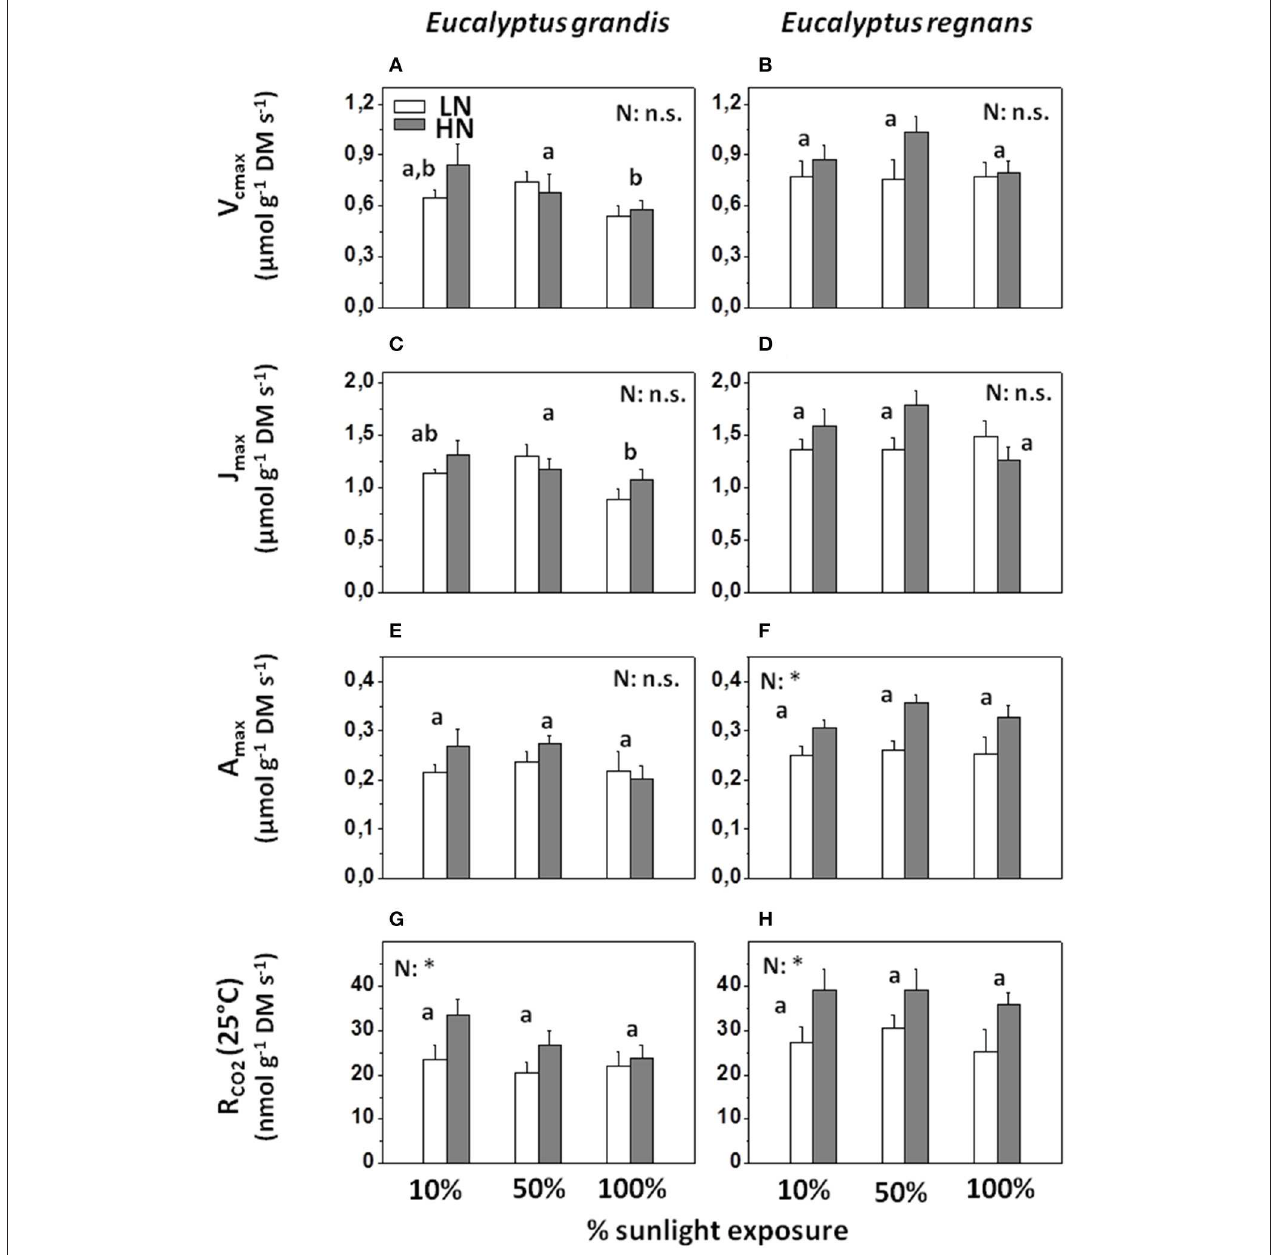
FIGURE 4 | Photosynthetic capacity and CO 2 dark-respiration (at 25 ◦ C) of Eucalyptus under differing N-nutrition and light intensity, determined via Infrared Gas Analysis. (A) Source-leaf V cmax in Eucalyptus grandis . (B) Source-leaf V cmax in Eucalyptus regnans . (C) Source-leaf J max in Eucalyptus grandis . (D) Source-leaf J max in Eucalyptus grandis Eucalyptus regnans . (E) Source-leaf A max in Eucalyptus grandis . (F) Source-leaf A max in Eucalyptus regnans . (G) Source-leaf R CO2 (CO 2 dark respiration at 25 ◦ C) in Eucalyptus grandis . (H) Source-leaf R CO2 (CO 2 dark respiration at 25 ◦ C) in Eucalyptus regnans . Open columns: “low” N-supply (LN: 2.6mM N). Gray columns: “high” N-supply (HN: 8.1mM N). Each column shows the average ± SE of 5–6 independent replicates. Different letters indicate significant differences between light regimes within species ( N = 11–12 for each factor group; post-hoc Tukey HSD-test). Asterisk (*) indicates significant N-treatment effect ( N = 17–18 for each factor group; n.s., not significant). N × L interactions within species were not significant. For effect sizes between species and treatments, see Table 2 . For analysis on leaf area basis, see Figure S1 and Table S2 .